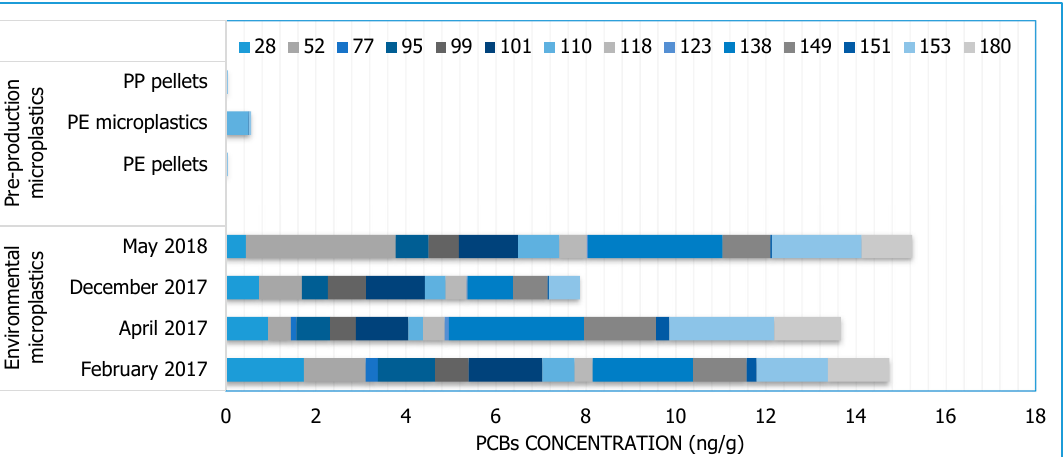
n e m n o i r n v E